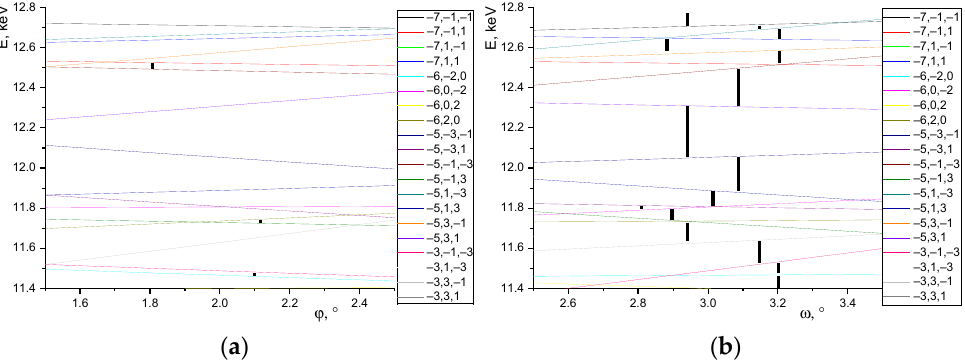
Figure 6. A possible path (bold black line) for avoiding glitches for a diamond crystal at 11.4–12.8 keV. ( a ) Glitches for fixed ω = 3°; ( b ) glitches for fixed ϕ = 2°.